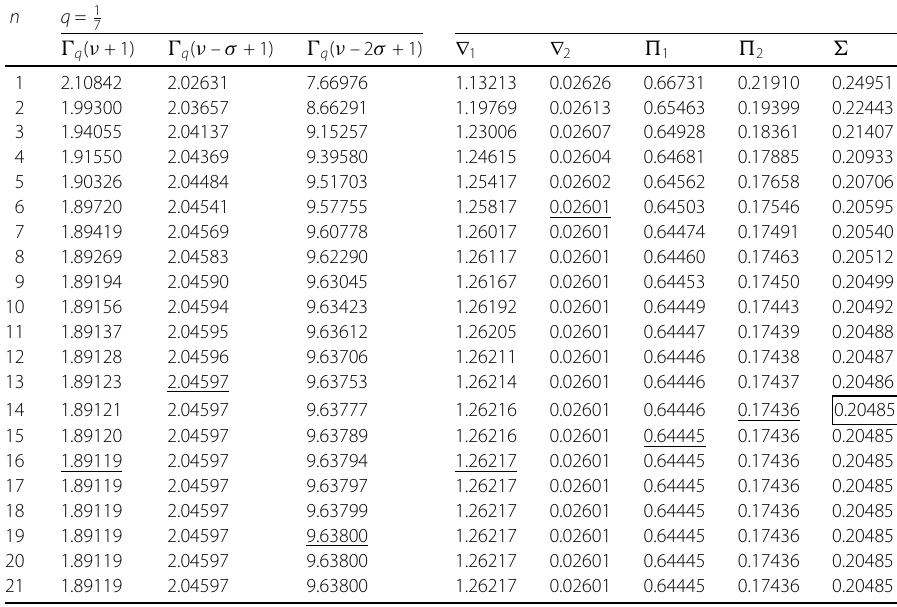
in Example 5.1 7